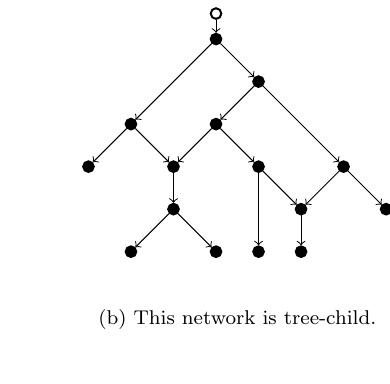
Figure 1. Examples of phylogenetic